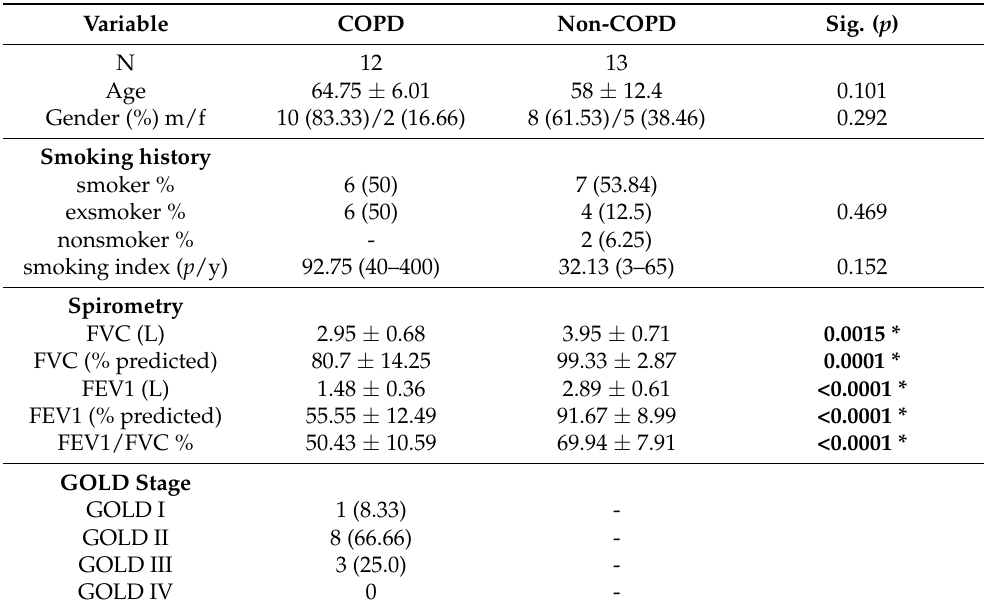
Table 1. Patients’ clinical